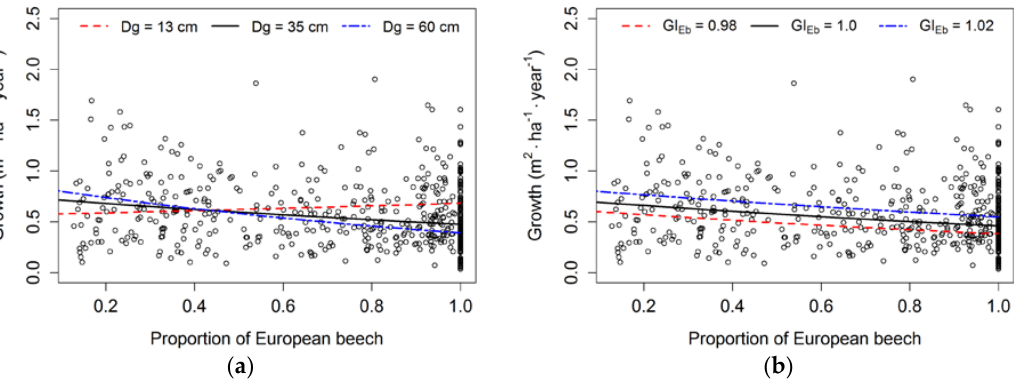
Figure 4. Effect of species proportion on European beech basal area growth per unit species proportion ( a ) depending on the quadratic mean diameter and ( b ) depending on the growth index. All the other explanatory variables are set to their mean values. GI Eb : growth index for European beech.